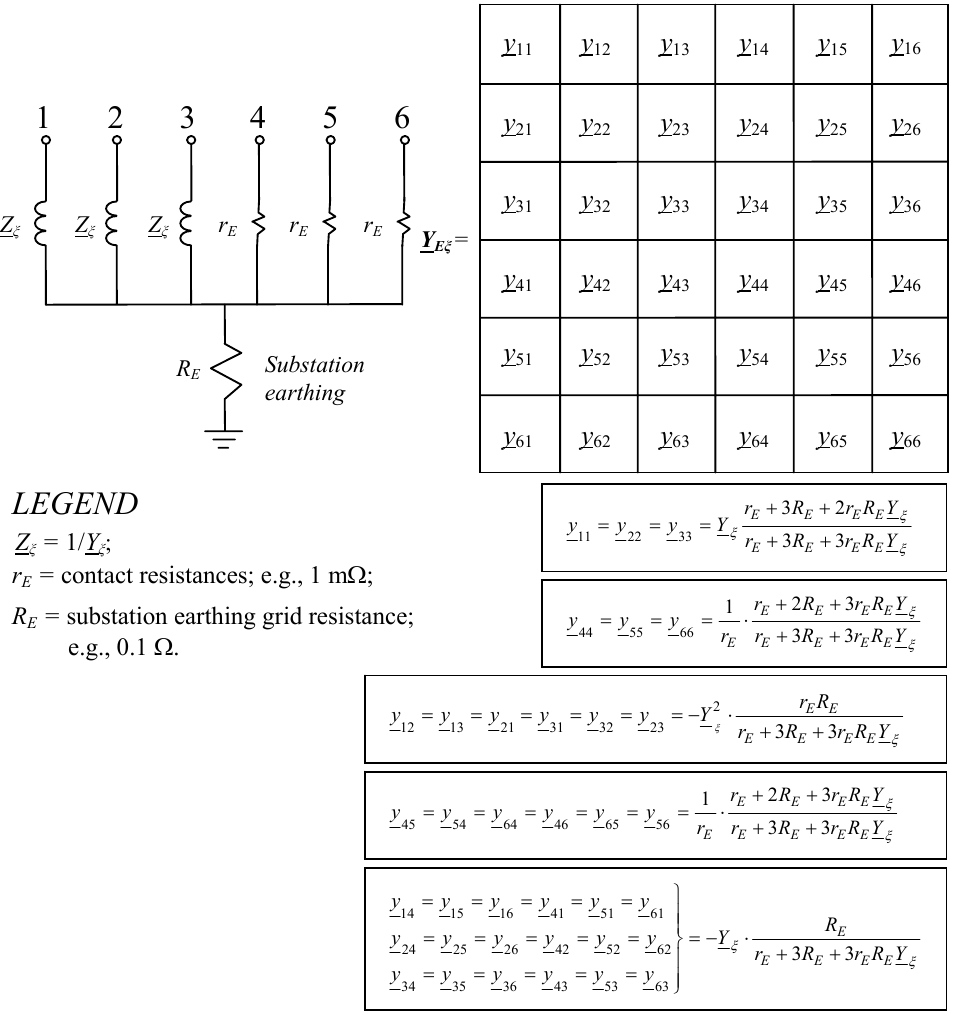
for shunt reactors and screen E ξ